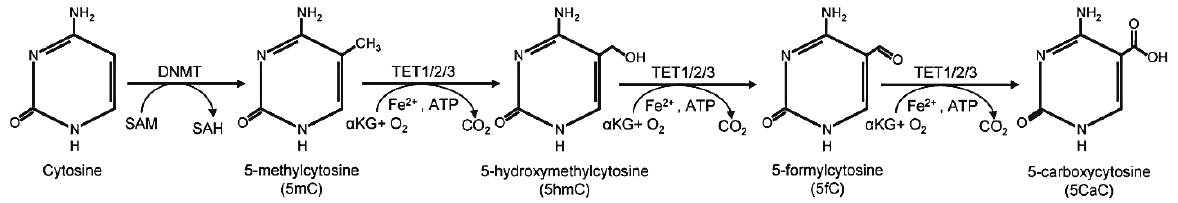
Figure 1. Generation of DNA methyl modifications. Cytosines are converted to 5-methylcytosine (5mC) by DNA methyltransferase (DNMT) enzymes through transfer of a methyl group from S -adenosyl methionine (SAM). Ten Eleven Translocation (TET) enzymes catalyze the oxidation of 5mC to 5-Hydroxymethylcytosine (5hmC) through a chemical reaction which involves alpha -ketoglutarate ((cid:2)KG), Oxygen (O 2 ), Adenosine triphosphate (ATP) and Fe 2+ . Similar reactions further oxidize 5hmC into 5-formylcytosine (5fC) and 5-carboxycytosine